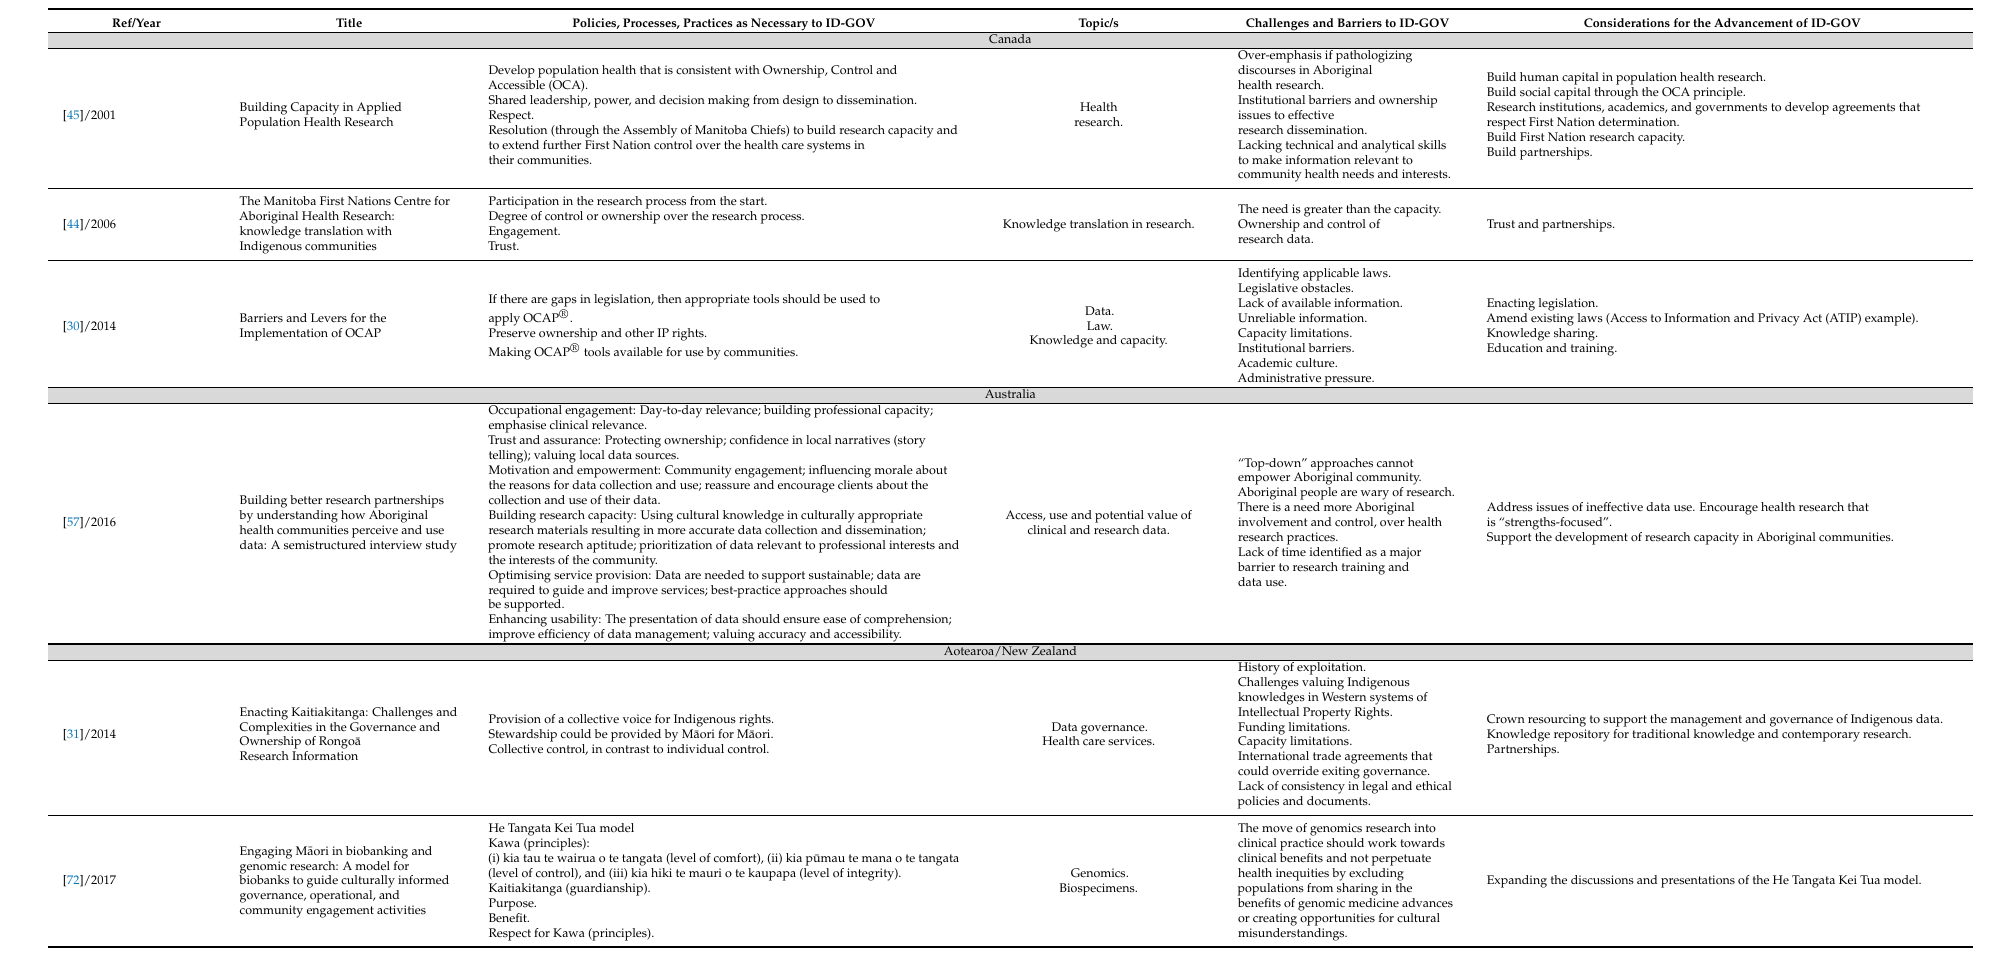
Table 3. Policies, processes and practices to advance